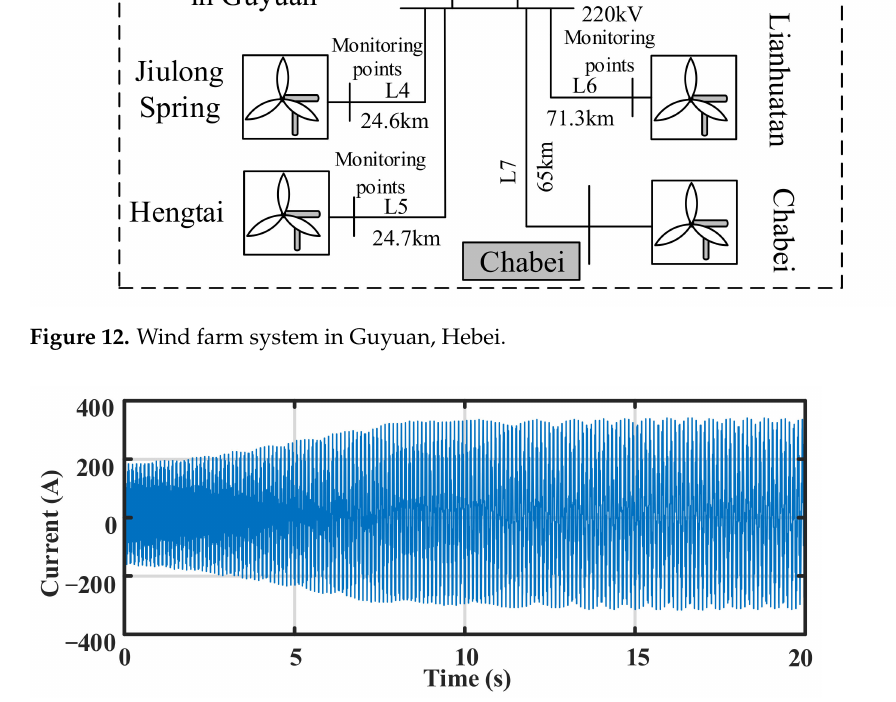
Figure 13. Current waveform of a wind farm in